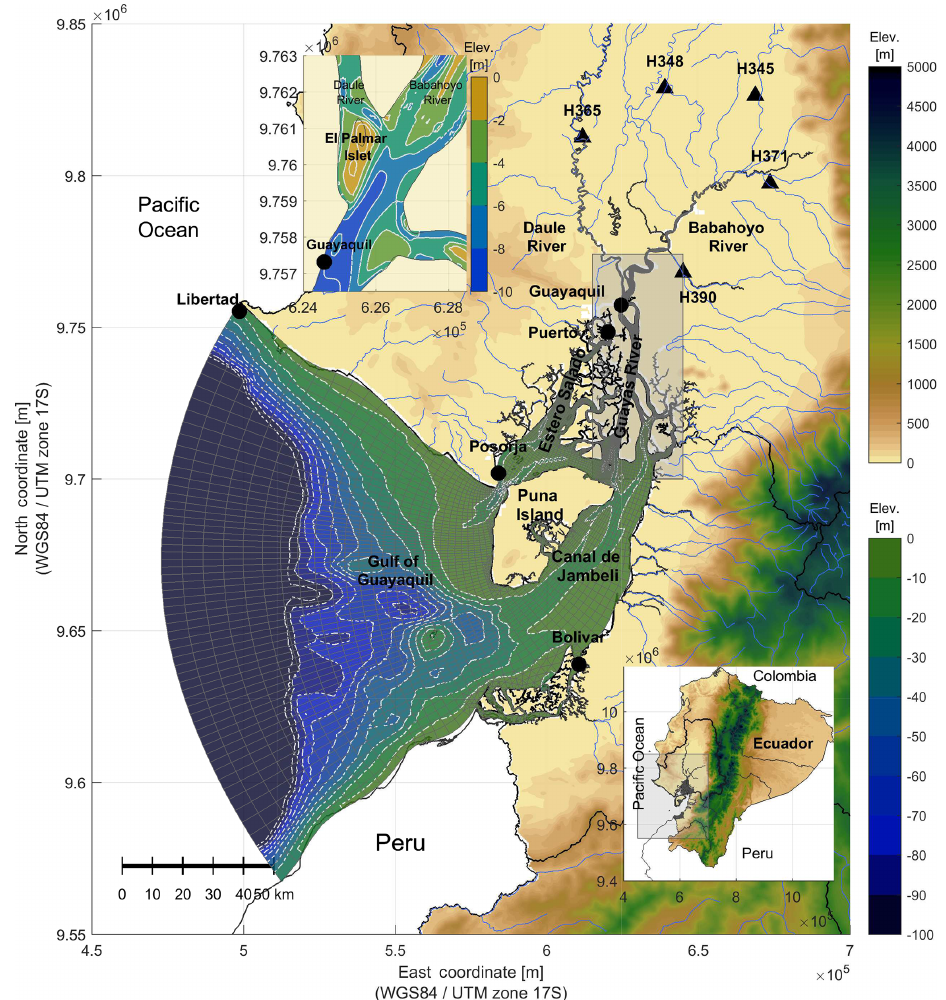
Figure 1. Map of the study area, covering the Gulf of Guayaquil, its estuary, and the Guayas River. The map also includes the numerical grid of the Delft3D FM model. Tidal stations are indicated by circles and river gauging stations by triangles, while the area of interest is enclosed in the rectangle. The bathymetry is indicated as contour line mapping depths every 10m, with contour lines deeper than 100m omitted from the